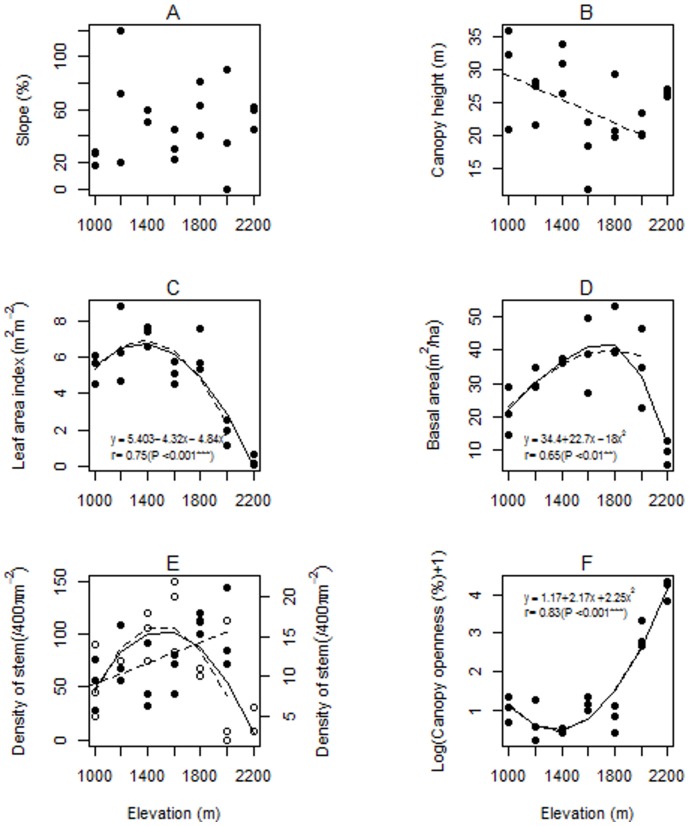
Relationships between elevation and slope, and between elevation and various components of forest structure on Mount Rinjani, Indonesia.A) slope, B) canopy height (y = 38.19+0.01x, R2 = 0.21), C) LAI, D) basal area, E) tree density, where filled circles are for subcanopy trees (y-axis on left, y = 3.68+0.05x, R2 = 0.25) and open circles are for canopy trees (y-axis on right, y = 12.39-0.48x-14.62x2, R2 = 0.33), and F) canopy openness. Solid lines indicate relationships including all elevation stations and the dashed lines indicate the relationships when the station at 2200 m (fire-maintained grassland) was omitted. Only significant (p<0.05) relationships are shown. The non-zero woody biomass and canopy height for the grassland station (2200 m) are because there were small numbers of isolated trees.